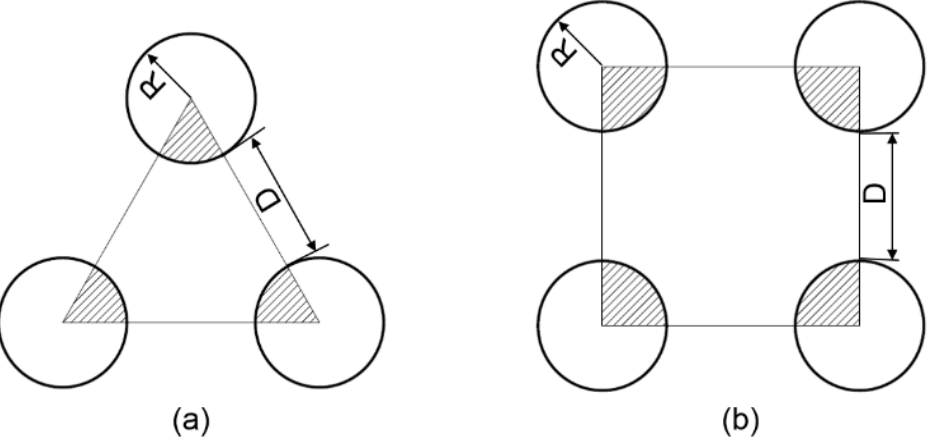
Figure 1. Basic periodic elements for two conventional hole array arrangements in GEMs. The shaded area is the effective optical transparency area in a basic element. ( a ) A hexagonal element. ( b ) A rectangle element.